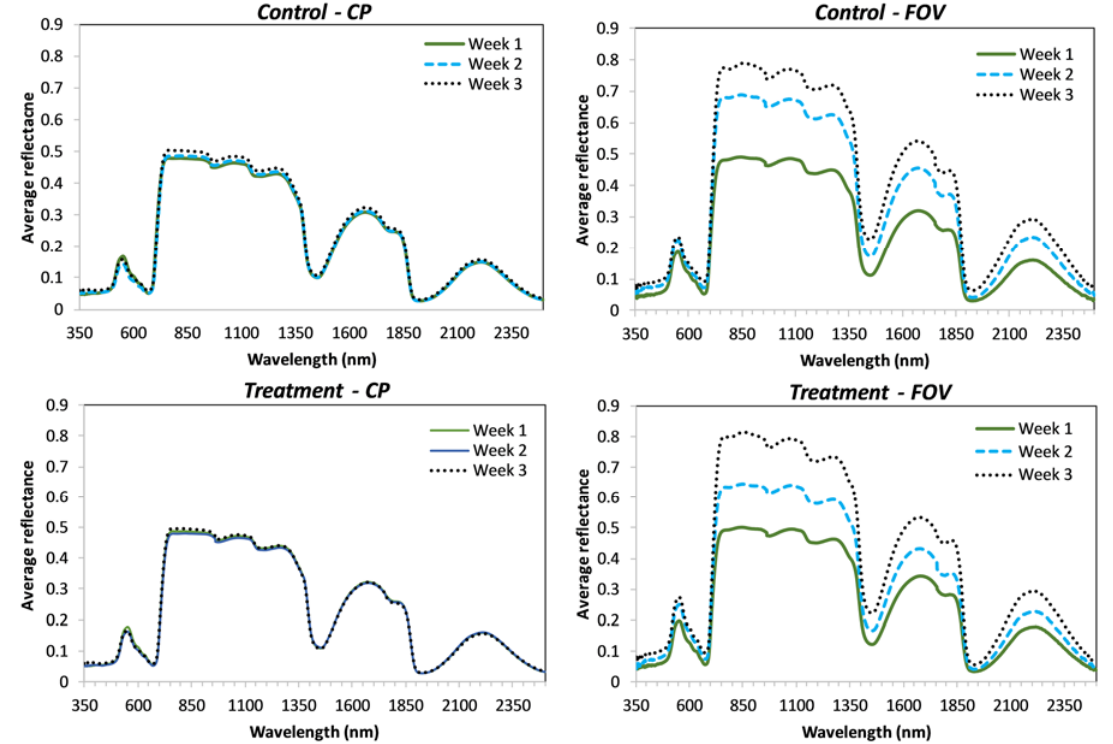
Figure A3. Control and treatment spectra for H. annuus as acquired by CP and FOV.